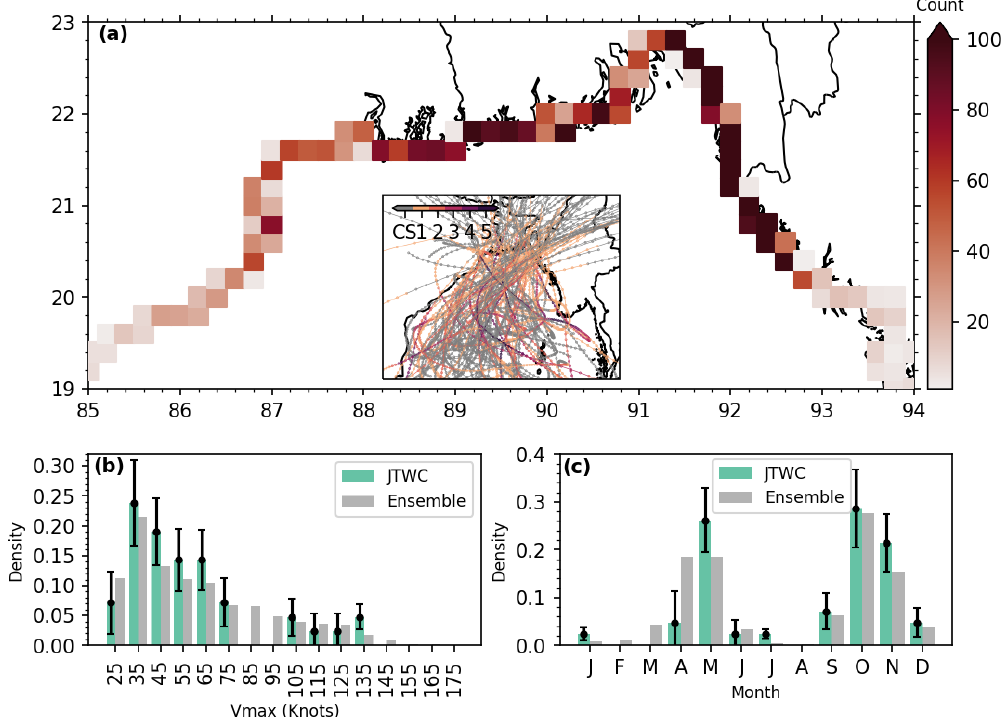
Figure 4. (a) Spatial distribution of the paths of the cyclones that make landfall along the coast of Bengal delta. Each square bin is 20km wide. A small subset of cyclone trajectories is shown in the inset. (b) Distribution of maximum wind speed of the synthetic cyclones compared to the JTWC dataset. (c) Annual distribution of the occurrence of the synthetic cyclones compared to JTWC dataset. In (b) and (c) , the error bar indicates the standard error associated with the small sample size in JTWC